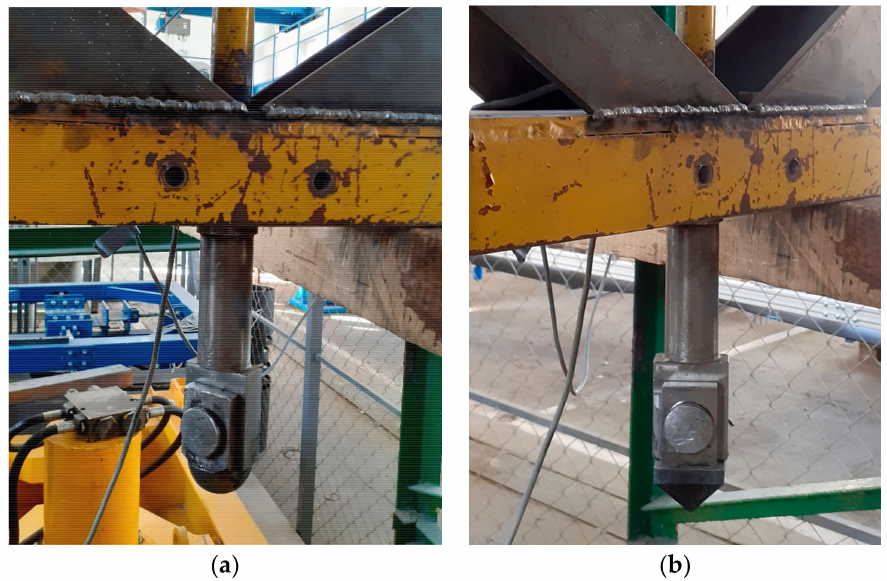
Figure 3. Impactors used: ( a ) spherical; and ( b ) pyramidal.